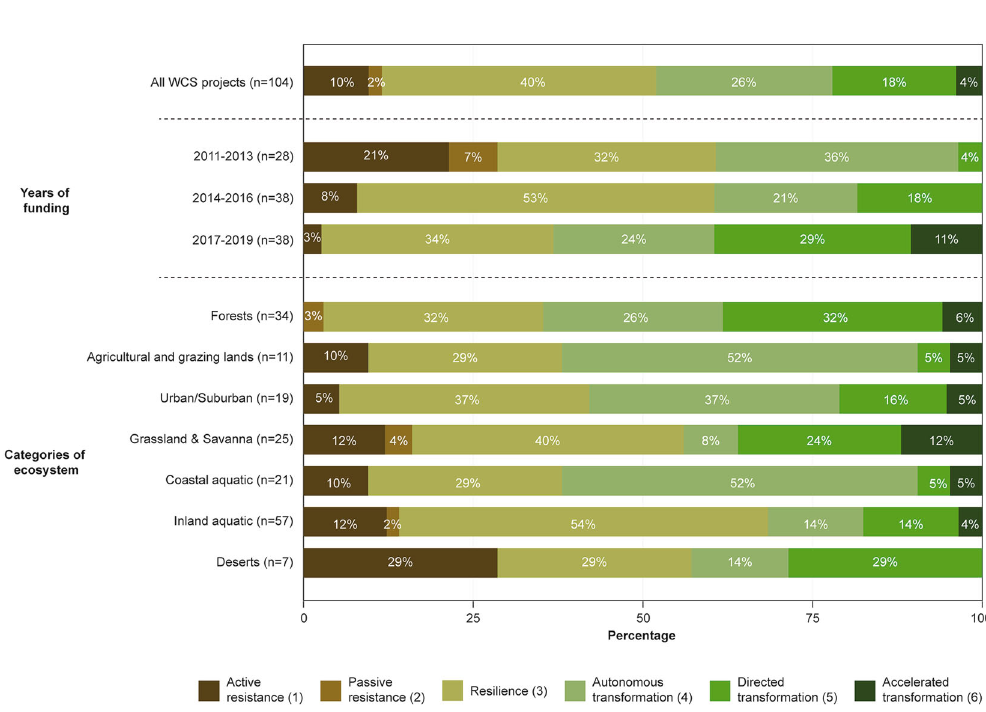
Fig. 2 Distribution of categories of adaptation projects using the R – R – T scale by years of funding (using groupings of three years) and type of ecosystems in which the projects were conducted. Some projects have been implemented in more than one type of